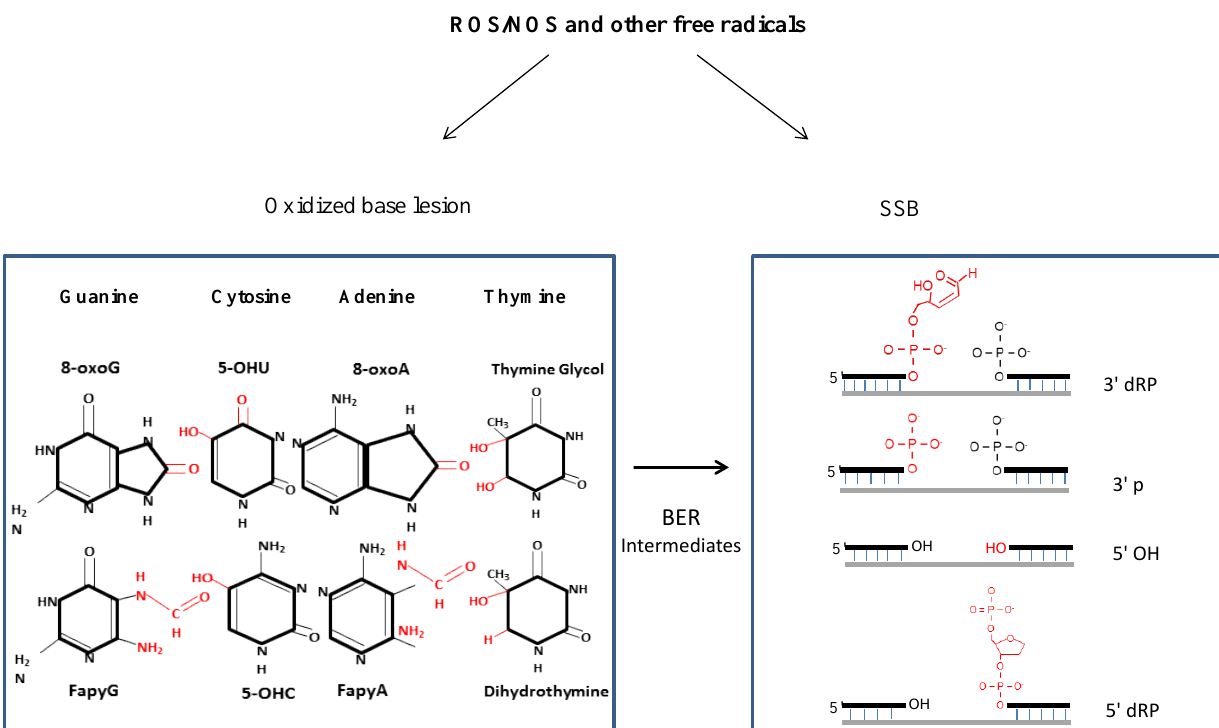
Figure 1. ROS and RNS are constantly produced during aerobic metabolism. ROS generate several dozen oxidized base lesions and single-strand breaks (SSBs) in the genome. SSBs are also generated as intermediates during the processing of oxidized bases via base excision repair (BER). ROS-induced SSBs contain diverse termini, like 3'-phosphoglycolate, 3'-phosphate, 5'-OH and 5'-deoxyribose